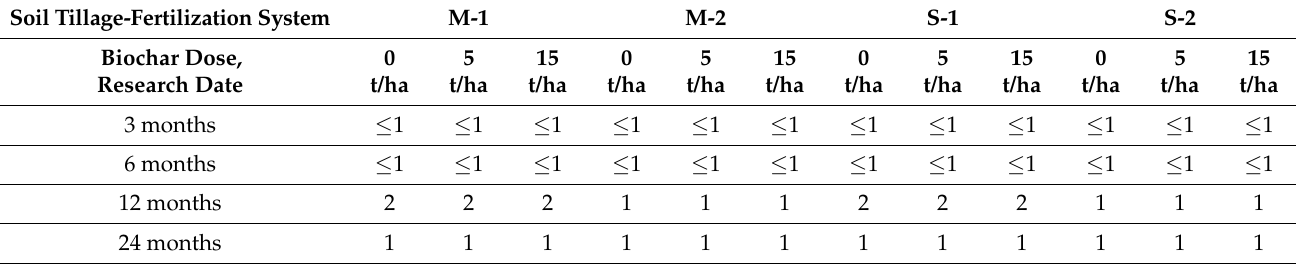
Table 7. Soil wettability assessed by water drop penetration time test under ploughless shallow